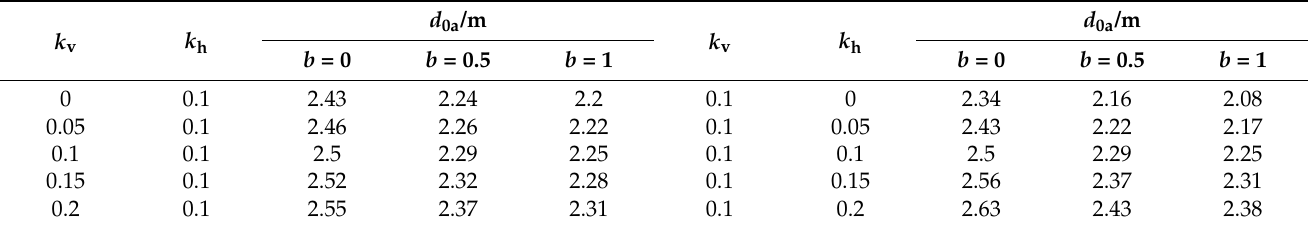
Table 3. Resultant location of Rankine active earth pressure and seismic coefficients.